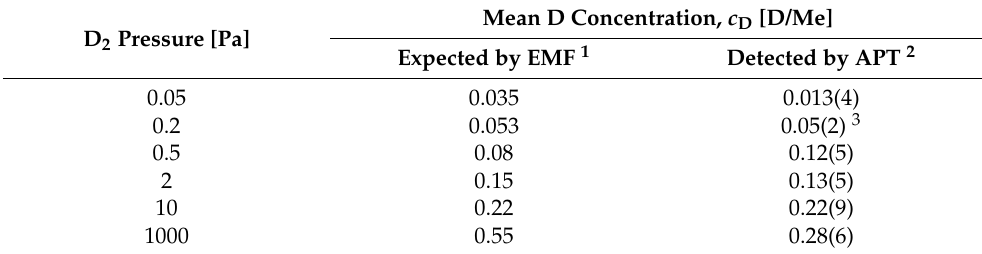
Table 1. Comparison of mean D concentration c D [D/Me] obtained by the EMF curve and APT.